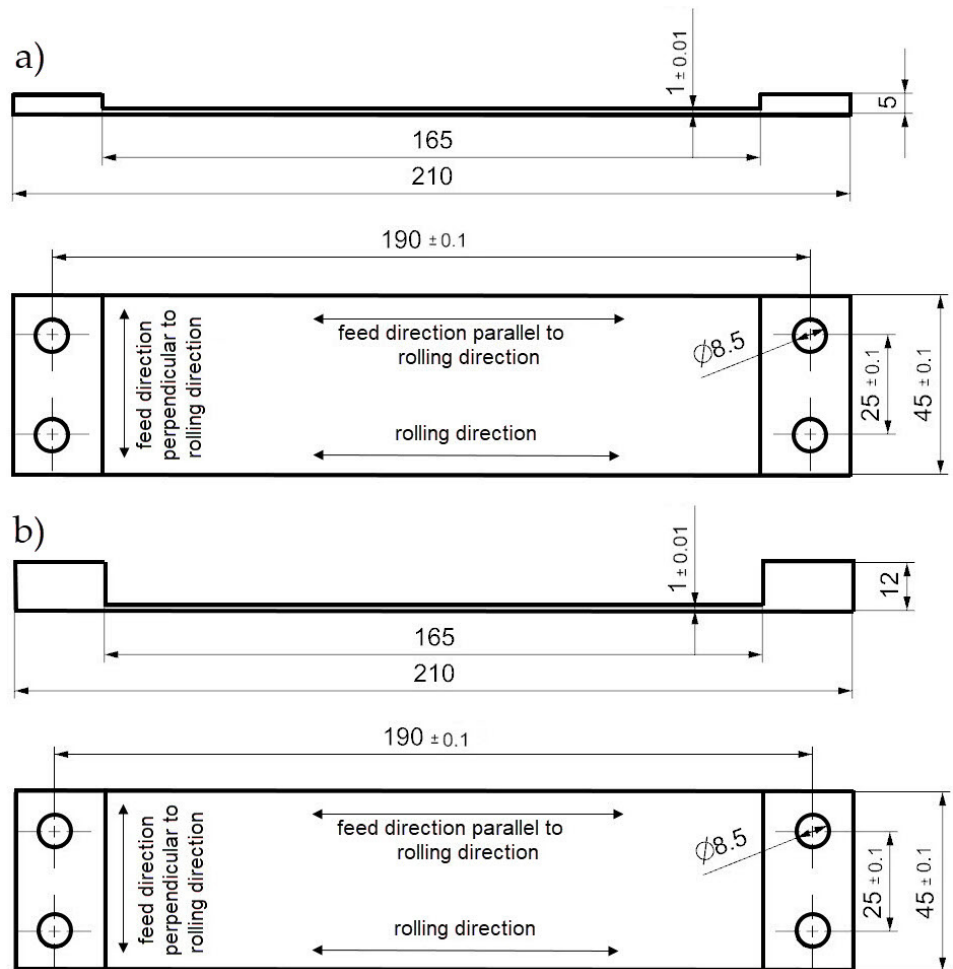
Figure 3. View of the sample after milling: ( a ) semi-finished product thickness: 5 mm, ( b ) semi- finished product thickness: 12 mm.